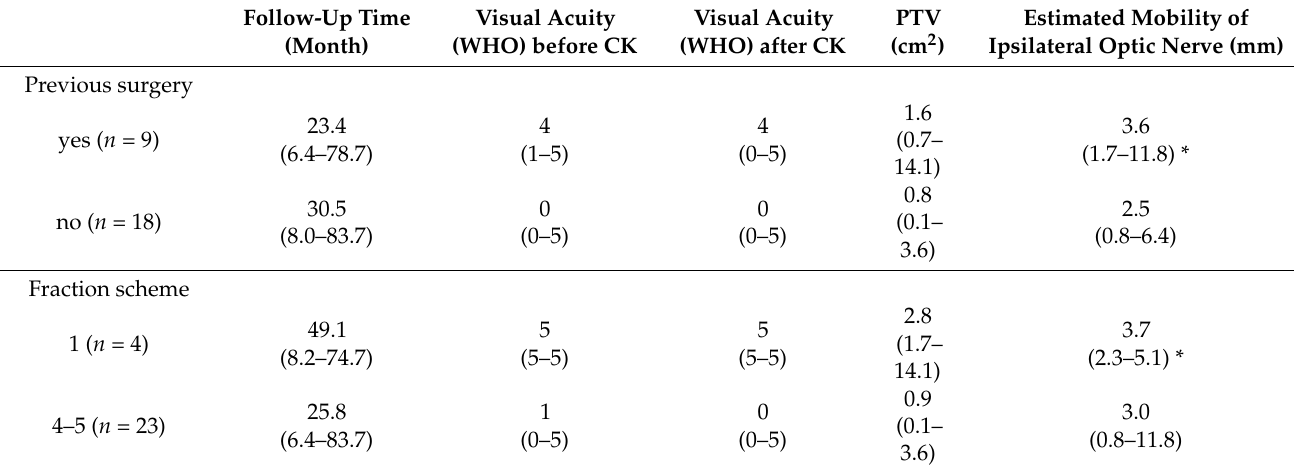
Table 2. Comparison of the different cohorts in regard to treatment and outcome. Visual outcome categorized according to the World Health Organization (WHO) categories separated by previous surgery and Cyberknife (CK) fractionation (reported as median, range).